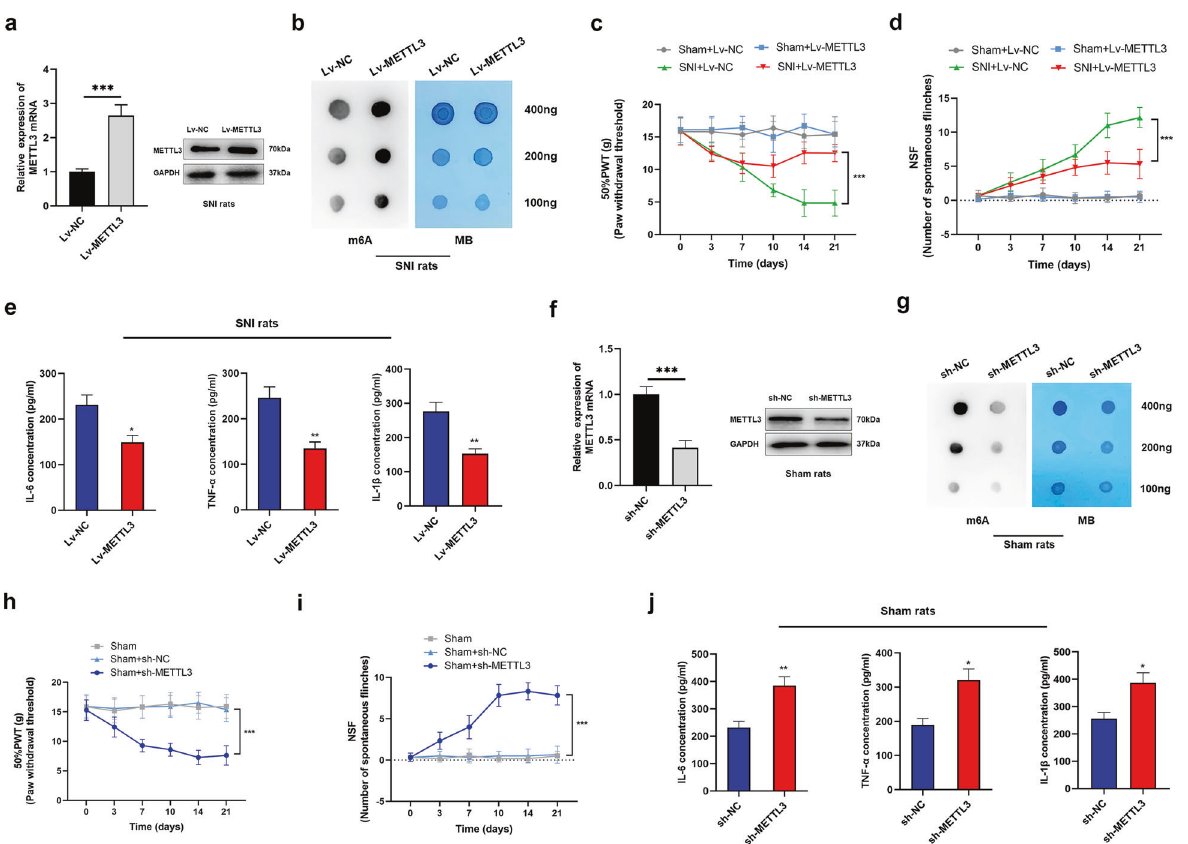
Methylene blue (MB) was used as experimental controls. The results showed an increased methylation of RNA upon overexpression of METTL3. c , d PWT ( c ) and NSF ( d ) analyses revealed that METTL3 overexpression signi fi cantly reversed the NP status of SNI rats, but showed no effect on sham rats. N = 5 biological replicates. *** P < 0.001. e IL-6, TNF- α and IL-1 β were detected in SNI rats via ELISA-overexpressed METTL3, and a signi fi cantly decreased expression of the above markers were identi fi ed. N = 3 biological replicates. * P < 0.05, ** P < 0.01 compared with Lv-NC group. f The expression of METTL3 was detected after injection of METTL3-silencing vectors into experimental rats, and the results showed that METTL3 was signi fi cantly downregulated. N = 3 biological replicates. *** P < 0.001. g Dot-blot assays with m6A antibody in spinal cord tissues after injection of METTL3-silencing lentivirus into SNI rats. Methylene blue (MB) was set as the loading control. A dramatically decreased methylation of RNA was found when METTL3 was silenced. h , i PWT ( h ) and NSF ( i ) of sham rats in the respective groups were tested. Silence of METTL3 induced the NP in sham rats. N = 5 biological replicates. ** P < 0.01. j In fl ammatory markers IL-6, TNF- α , and IL-1 β were detected via ELISA and found to be upregulated by the silence of METTL3 in sham rats. * P < 0.05, ** P < 0.01 compared with control group. The experiment was repeated three times with similar